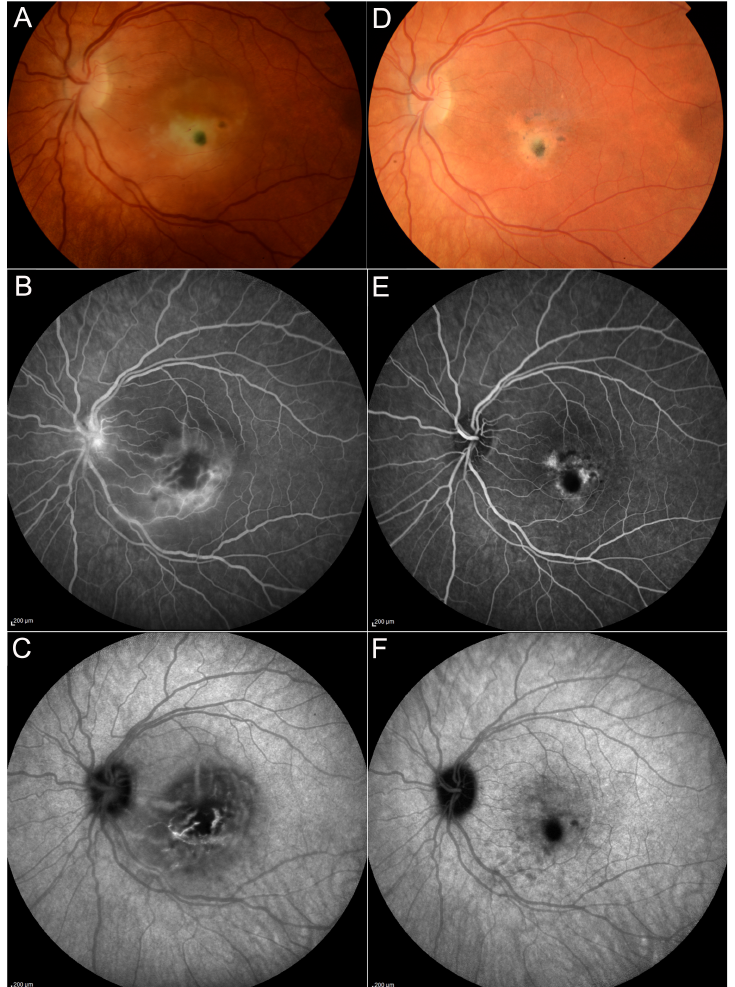
Figure 12. Case 4, Punctate outer retinal toxoplasmosis. Fundus examination ( A ) showing the presence of a yellowish lesion with a central grey spot on the macula, with indefinite borders, associated with perilesional edema. FA in the late phase displayed the presence of an enlarged foveal avascular zone (FAZ) corresponding to the area of detachment with perilesional leakage and papillitis ( B ). Intermediate phase ICGA evidenced a macular hypocianescent area with indefinite borders and hypercianescent striae inside the lesion ( C ). After the treatment, macular edema resolved ( D ). FA evidenced the presence of a hypofluorescent macular scar associated with RPE alterations (hyperfluorescent) in the early and late stages of the exam ( E ); a hypocianescent area is visible on ICGA ( F